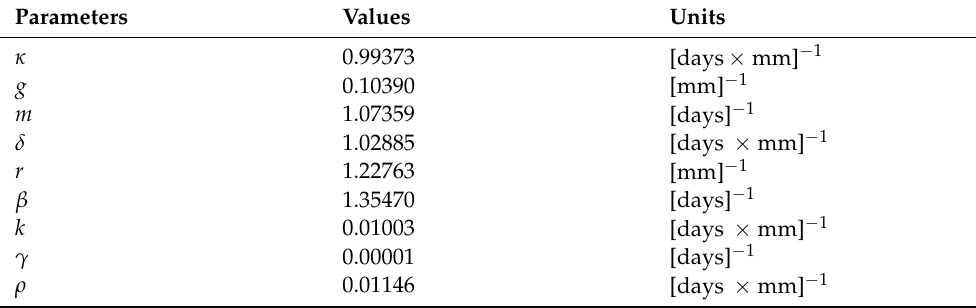
Table 2. Proposed model resulting